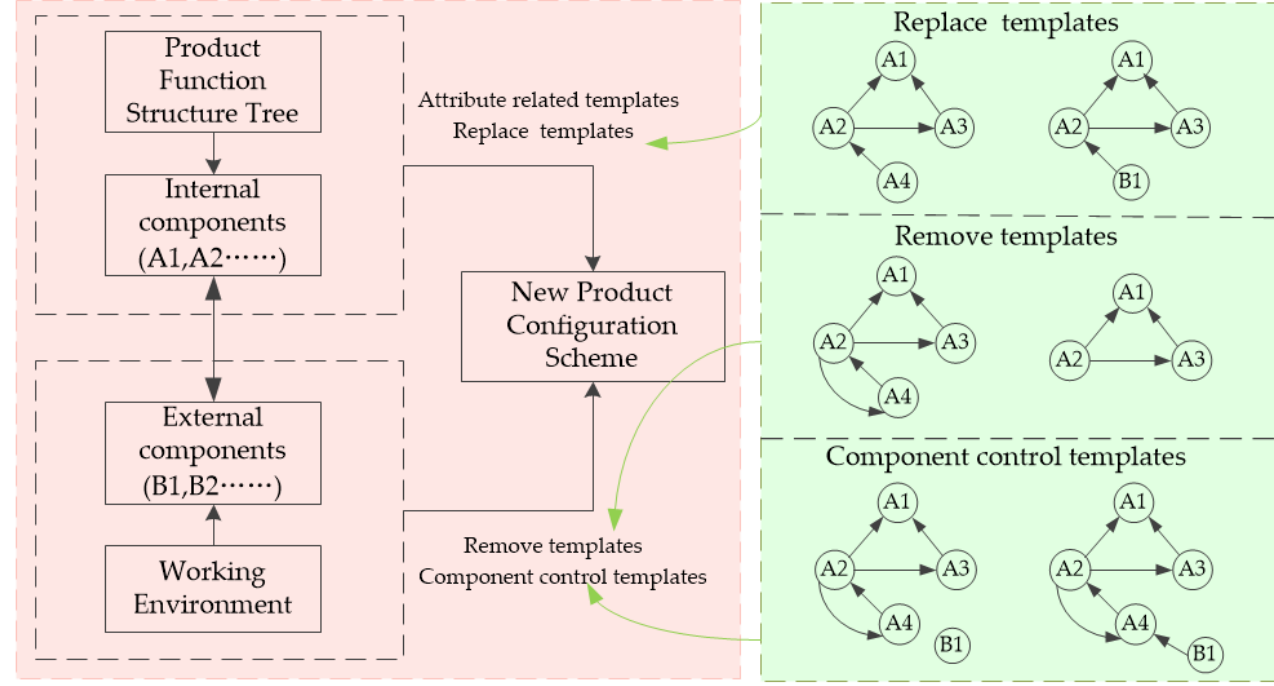
Figure 4. Schematic diagram of the creative template method application.